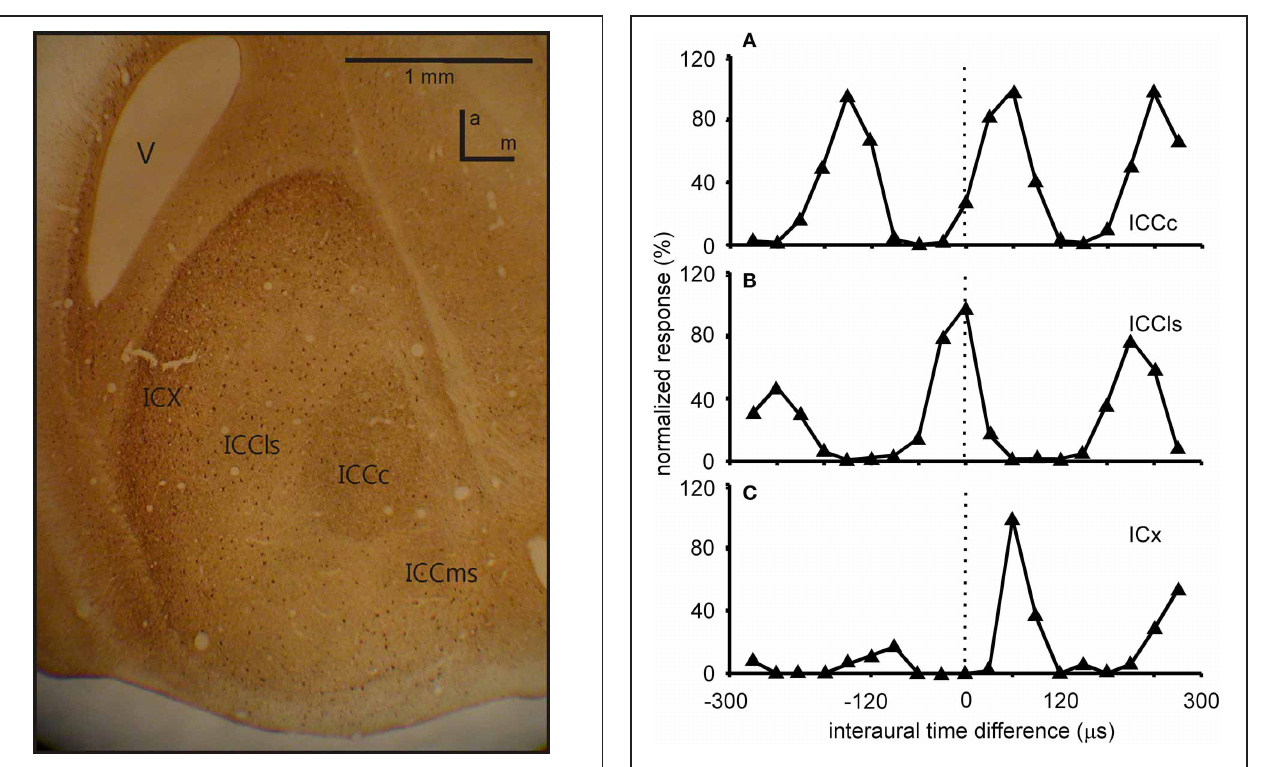
FIGURE 2 | IC anatomy. A horizontal section through IC with the four important sub-nuclei. Photograph from a staining with Calbindin. V , ventricle; a , anterior; m , medial.